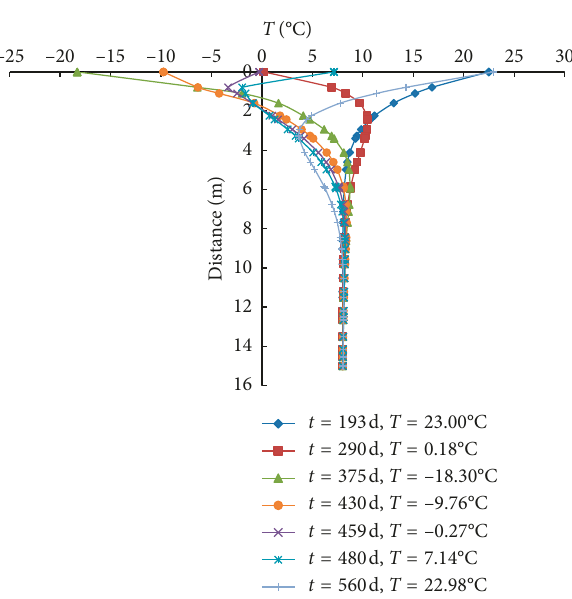
Figure 7: Temperature distribution of the slope waist along vertical distance from slope surface at different times.